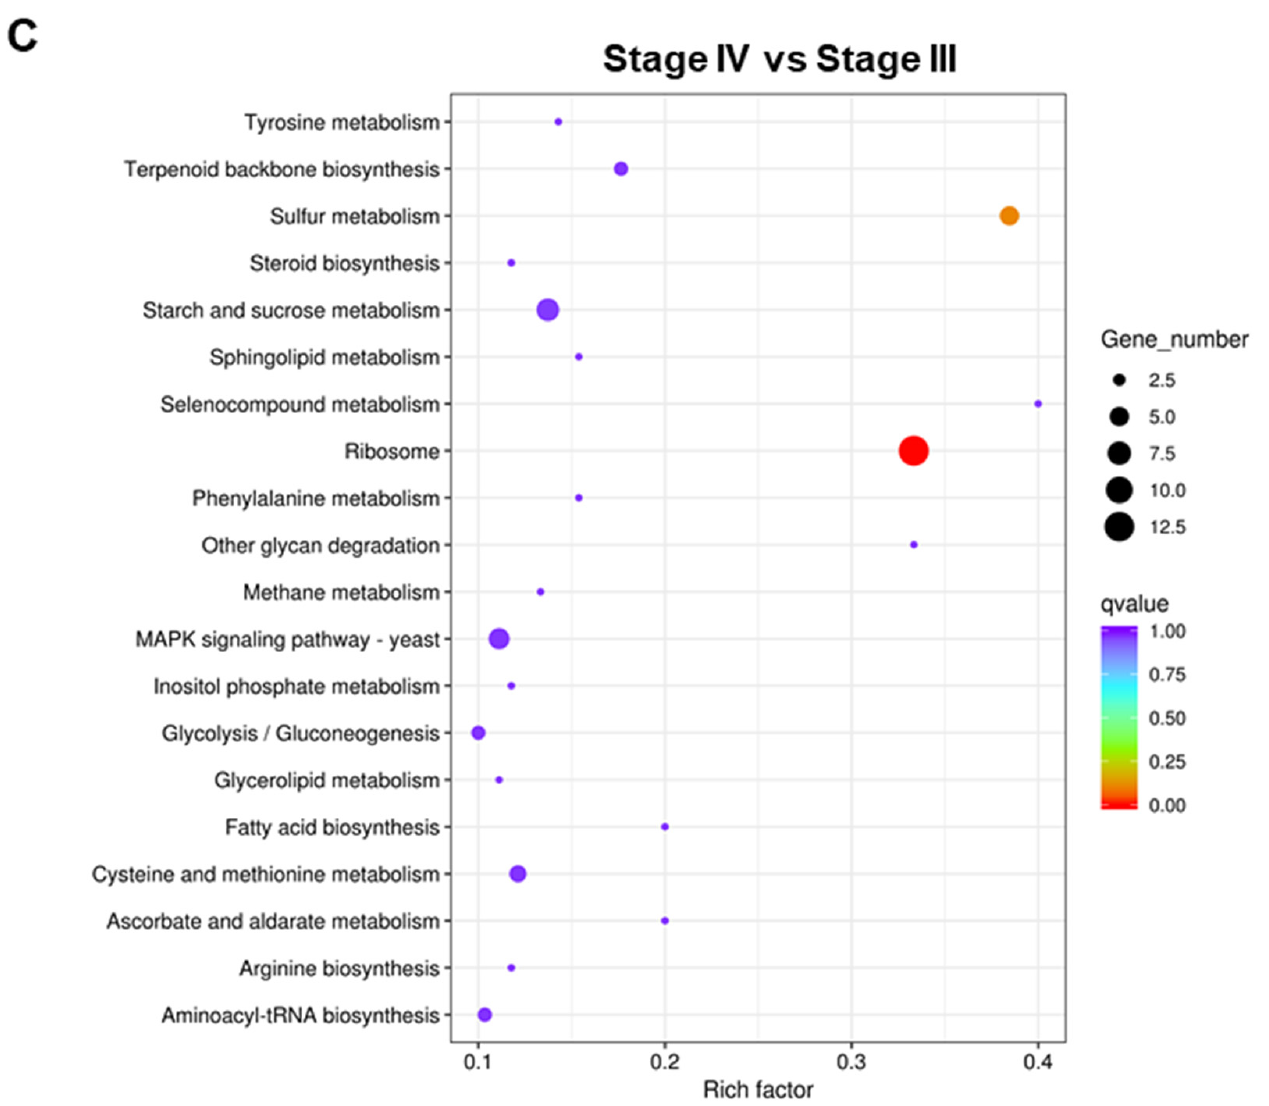
Figure 7. The top 20 enriched KEGG pathways of DEGs. ( A ) Stage II vs. Stage I; ( B ) Stage III vs. Stage II; ( C ) Stage IV vs. Stage